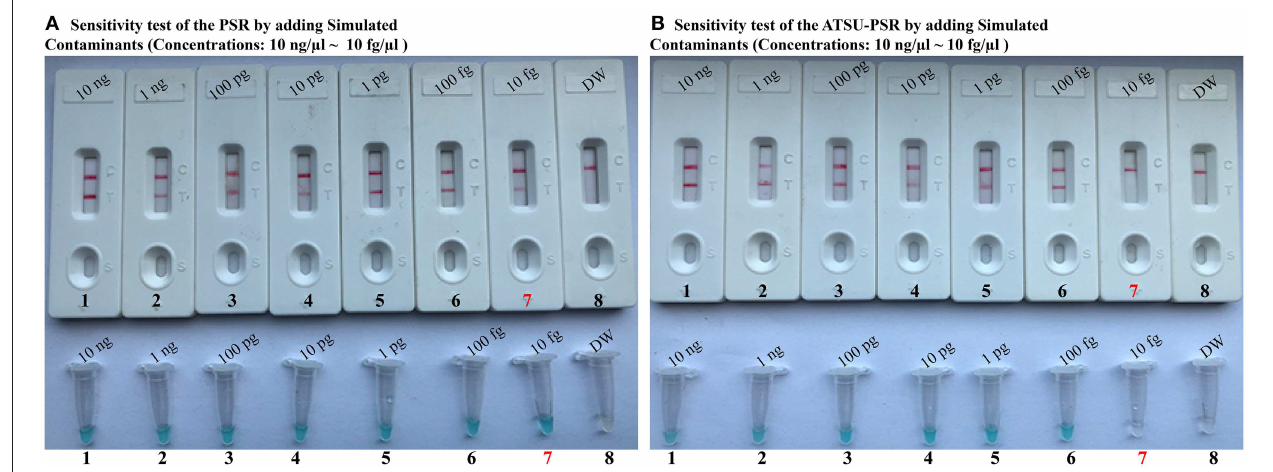
FIGURE 5 | Uracil-DNA-glycosylase-supplemented polymerase spiral reaction (ATSU-PSR) assay prevents false-positive result due to carryover contaminants. Sensitivity of conventional PSR (A) and ATSU-PSR technique (B) using serial dilutions (10 ng µ l − 1 , 1 ng µ l − 1 , 100 pg µ l − 1 , 10 pg µ l − 1 , 1g µ l − 1 , 100 fg µ l − 1 , and 10 fg µ l − 1 ) of American Type Culture Collection (ATCC) BAA-2146 and 1 × 10 − 18 g µ l − 1 of simulated carryover contamination (dUTP-incorporated PSR products) as determined using biosensor and visual detection reagent.